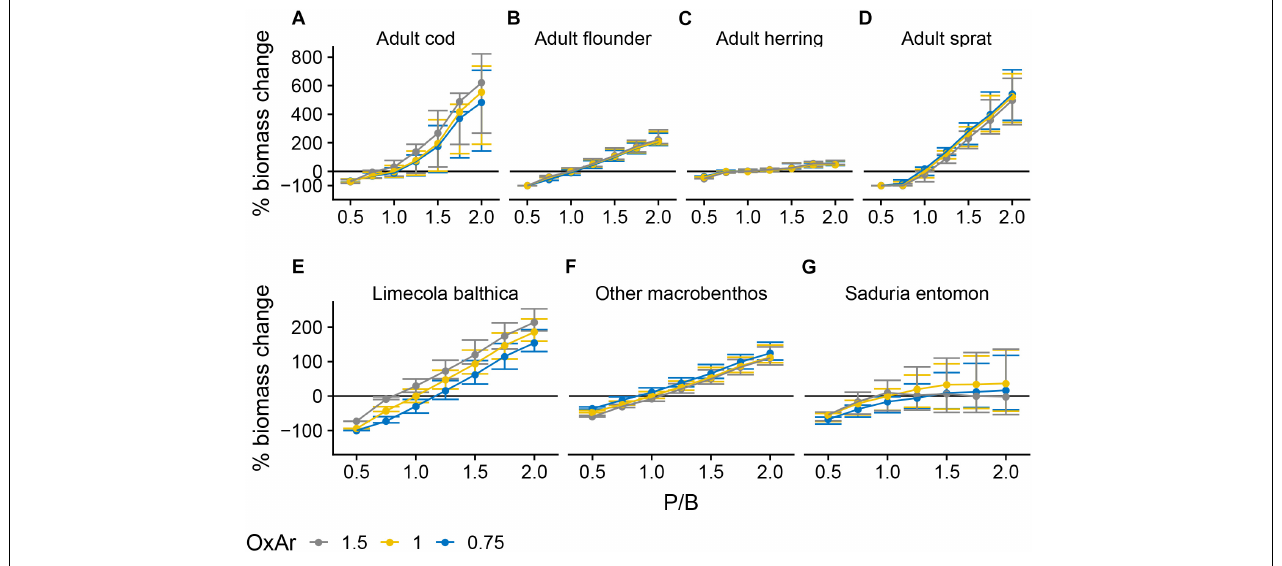
FIGURE 3 | Change in biomass of cod (A) , flounder (B) , herring (C) , sprat (D) , Limecola balthica (E) , “other macrobenthos” (F) , and Saduria entomon (G) as a function of relative changes in P/B and OxAr, where 1 denotes baseline forcing. Biomass change is relative to baseline equilibrium value. Error bars show the variability in biomass change due to varying TSurf and CodRV. Horizontal line indicates no change. Results from simulations with CodRV = 0, resulting in 0 cod biomass, are excluded from the figure. Forcing abbreviations are explained in Table 1